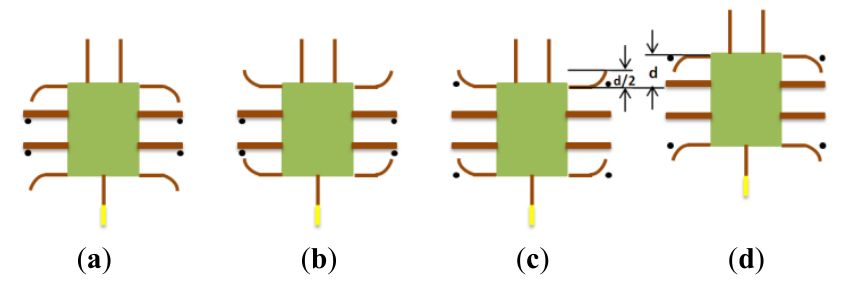
Figure 16. One step cycle of moving forward motion in lying structure (The marks ● indicate which actuator contacts the